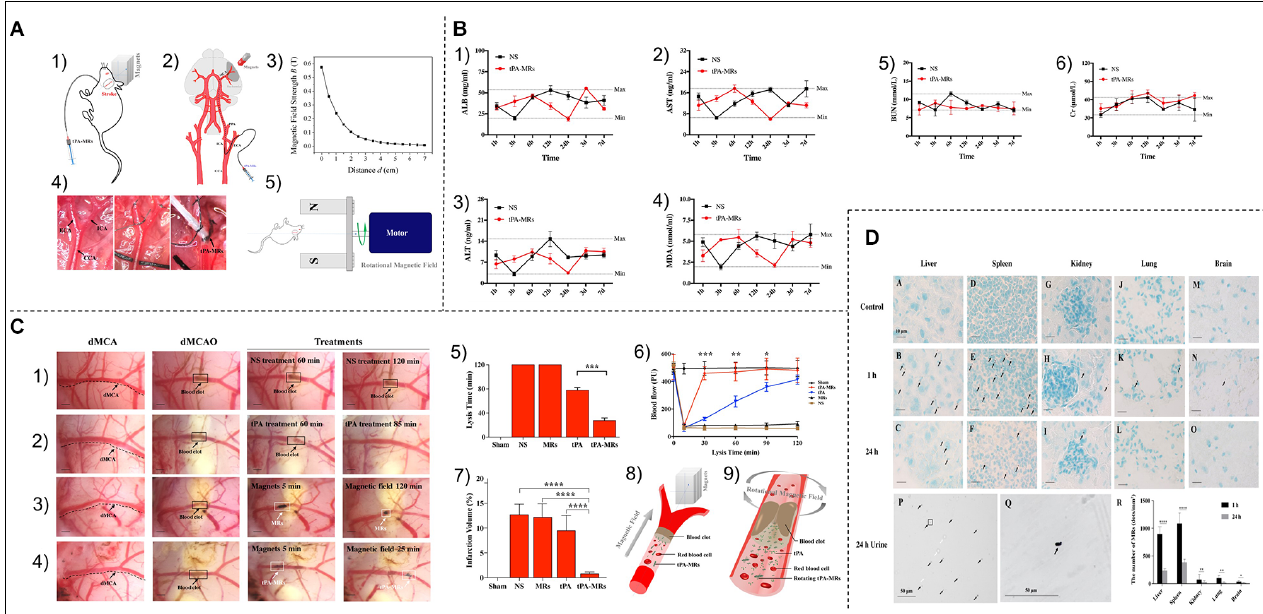
FIGURE 4 | (A) (1,2) Schematic diagram of tPA-MRS injection and surgical operation. (3) Magnetic field strength of the magnet used for MRS or tPA-MRS guidance at different distances. (4) ICA injection route in the dMCAO mouse model. (5) During thrombolysis, the mouse head is placed in an applied eight rotating magnetic field. cCA, common carotid artery; ECA, external carotid 9 artery; ICA, internal carotid artery; PPA, pterygopalatine artery; MCA, middle cerebral artery. (B) tPA-MRS-mediated thrombolysis in a mouse model of stroke. (1) Representative images of thrombolysis in saline (NS)-treated dMCAO mice. (2) Thrombolysis in the tPA group within 85 min after injection. (3) Representative images of thrombolysis in dMCAO mice treated with MRS under four rotating magnetic fields. (4) The tPA-MRS solution group lysed the thrombus within 25 min under the rotating magnetic field. (5) Recanalization time graph of dMCAO mouse model under rotating magnetic field. (6) Laser Doppler detection of mice, DMCA blood flow in mice before and after thrombus formation in the DMCA and during thrombolysis. (7) Measurement of ischemic cerebral infarct volume at 24 h after stroke by TTC staining. (8) A protocol on how magnetic tPA-MRS targets on-site cerebral blood clots. (9) Mechanisms of magnetic tPA-MR-mediated thrombolysis. (C) Quantification of blood biomarkers of liver and kidney function. Mice were injected with tPA-MRs suspension or saline in the jugular vein (control group). The concentrations of three biomarkers of the liver (1–3) , kidney (5,6) function, and lipid peroxidation (4) were measured at different time points after injection, respectively. The data showed no significant differences between the NS group and the four tPA-MRS-treated groups for each biomarker throughout the experimental period. (D) Distribution and clearance of tPA-MRS in vivo . Liver (A–C) , spleen (D–F) , kidney (G–I) , lung (J–L) , and brain (M-30) of CD-1 mice after administration of tPA-MRS (1 mg/kg) for 1 h and 24 h. Typical Methyl Green 2 stained histological images, scale bar (A–L) = 4 10 µ m, black arrows indicate tPA-MRS. Representative images are available for urinalysis 2 h, 4 h, 5 h after tPA-MRS (P,Q) injection. Black arrows indicate detection of tPA-MRS in urine and white seven arrows indicate feed residues in the metabolic cage during urine collection. (R) Quantitative analysis of 1 h and 24 h tPA-MRS distribution. * P < 0.05; ** P < 0.01; *** P < 0.001; **** P < 0.0001. Reprinted (adapted) with permission from Hu et al. (2018). Copyright 2018 American Chemical